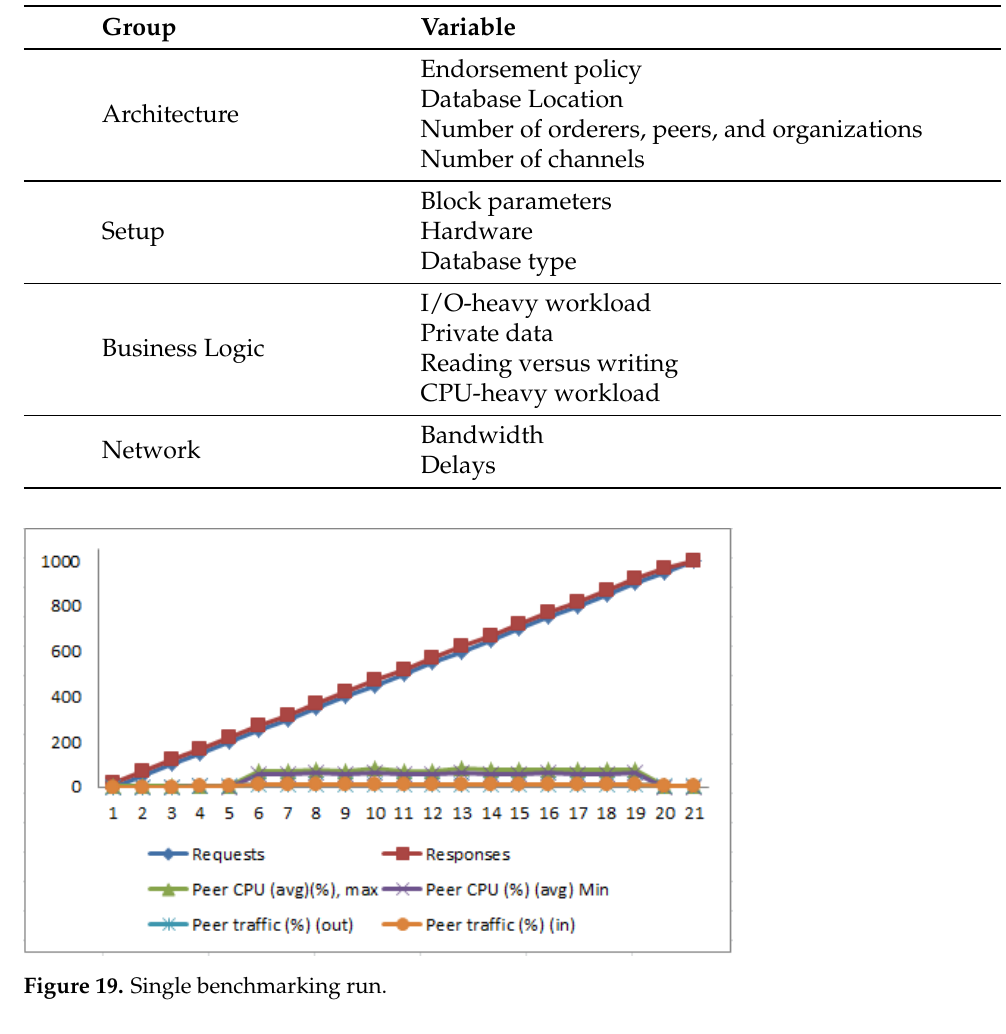
Table 9. Variables.